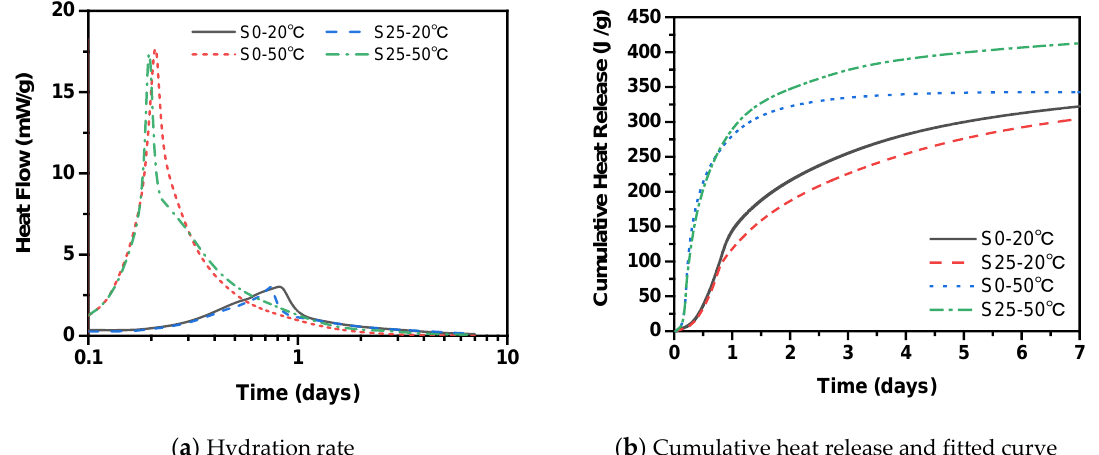
Figure 6. Hydration rate and cumulative heat release of cement paste with and without slag at different temperature.